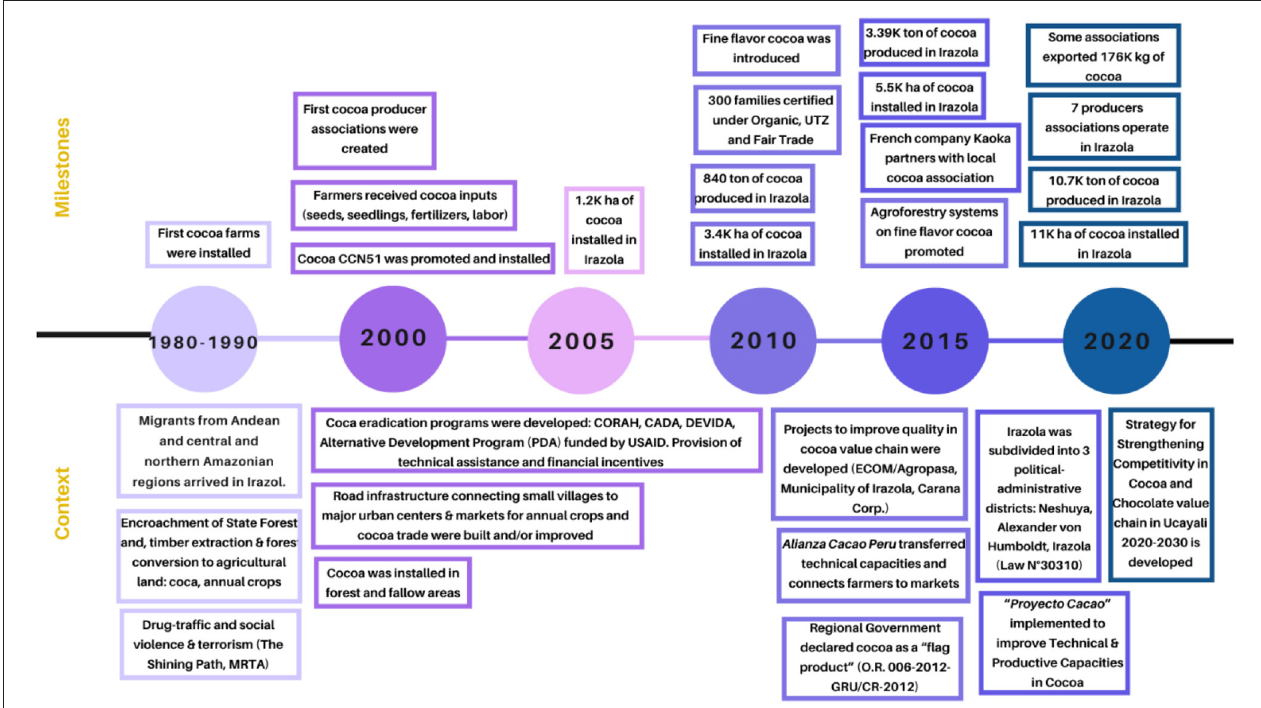
FIGURE 5 | Timeline (milestones and context) of cocoa cultivation in Irazola, Ucayali,